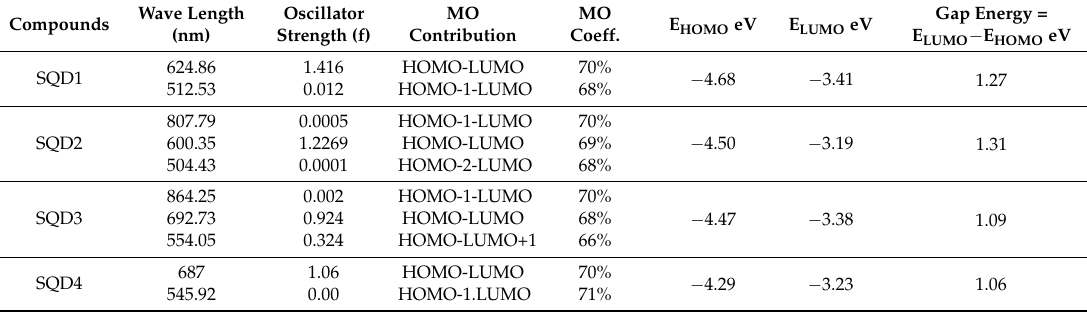
Figure 3. The UV-visible absorption spectra of SQD1–SQD4 dyes calculated using PBE/6-311++G** level of theory in methanol. Table 1. Absorption wavelength (nm), molecular orbital contribution, energy level of HOMO, LUMO and gap energy and oscillator strength calculated by using PBE/6-311++G** for squaraine studied dyes in the gas phase.